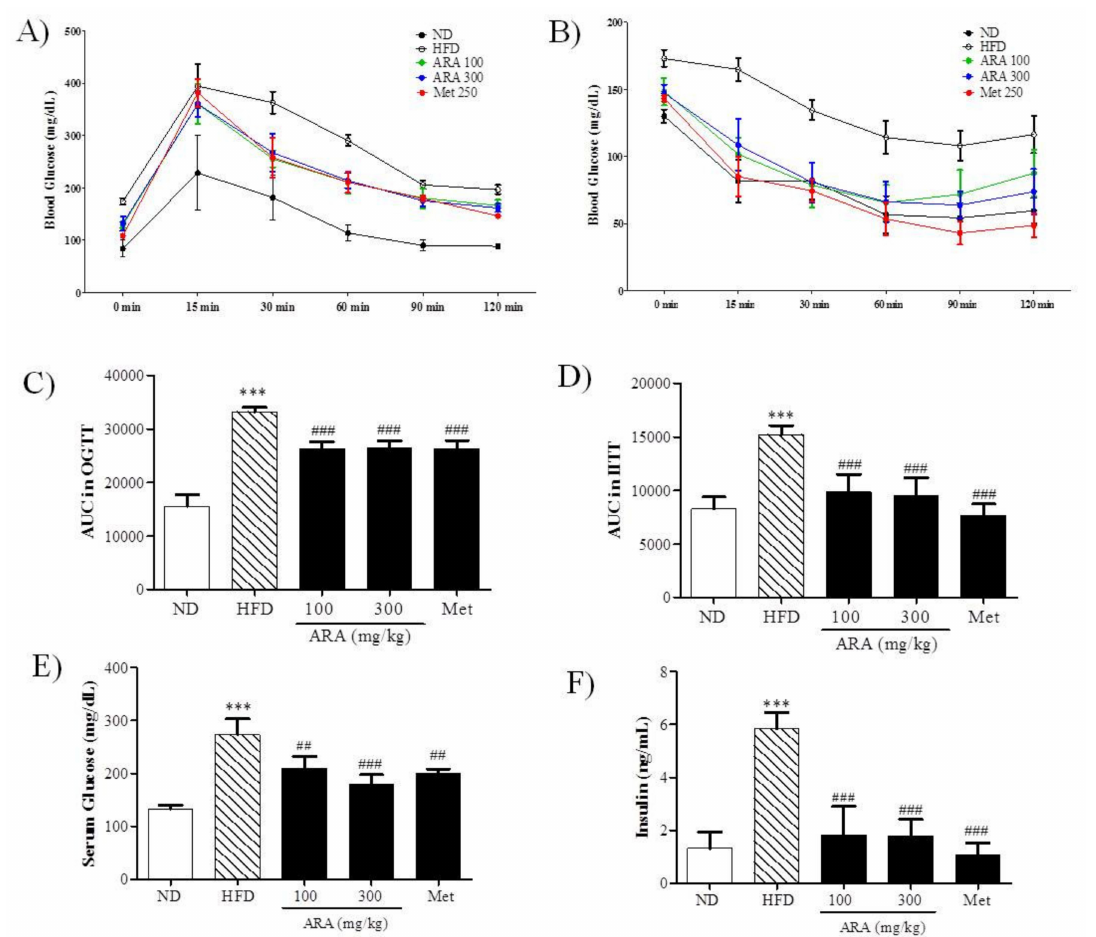
Figure 2. Effects of ARA on glucose metabolism. ( A ) oral glucose tolerance test (OGTT); ( B ) intraperitoneal insulin tolerance test (IITT); ( C ) AUC in OGTT; ( D ) AUC in IITT; ( E ) fasting serum glucose; ( F ) serum insulin. Results are presented as means ± standard errors of the mean (SEM) ( n = 5). *** p < 0.001 versus normal chow fed controls (the ND group); ### p < 0.001, ## p < 0.01 versus the high fat diet fed mice (the HFD group). AUC, area under the